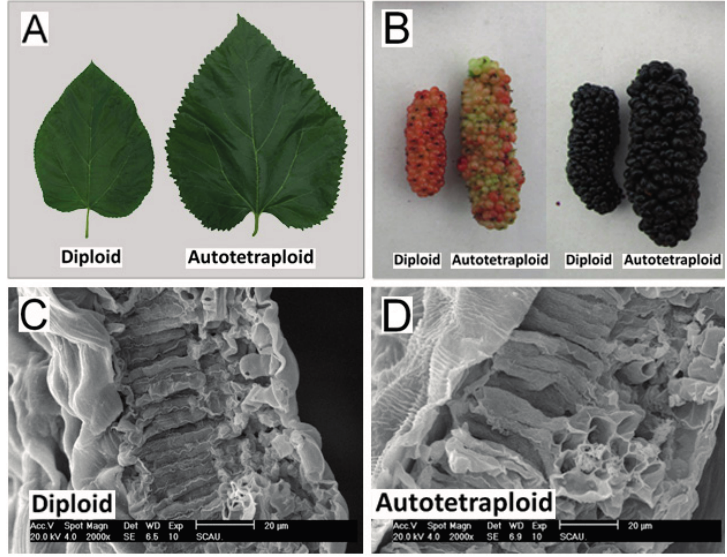
Figure 2. Phenotypic characterization of diploids and autotetraploids grown under the same conditions. ( A ) Leaves of diploids and autotetraploids; ( B ) Fruits of diploids and autotetraploids at the red ( left ) and black ( right ) fruit stages; ( C ) Leaf cross-section of a diploid; and ( D ) Leaf cross-section of an